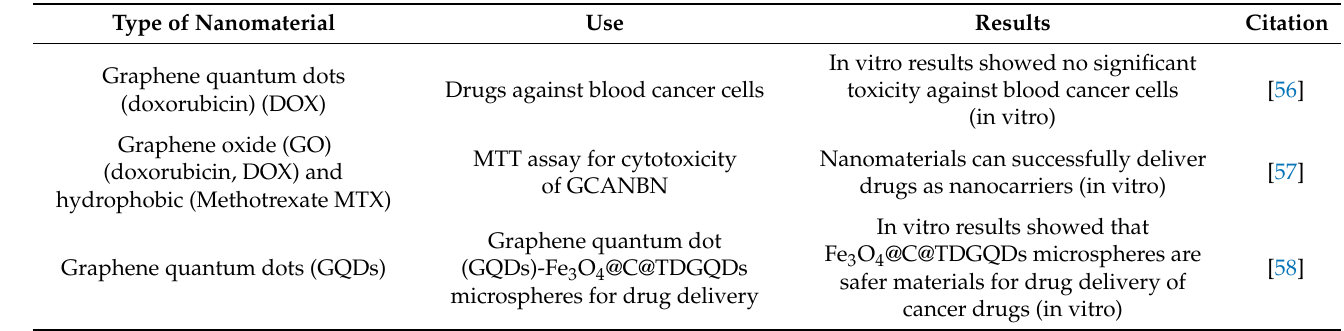
Table 6. Application of graphene-based nanomaterials in cancer